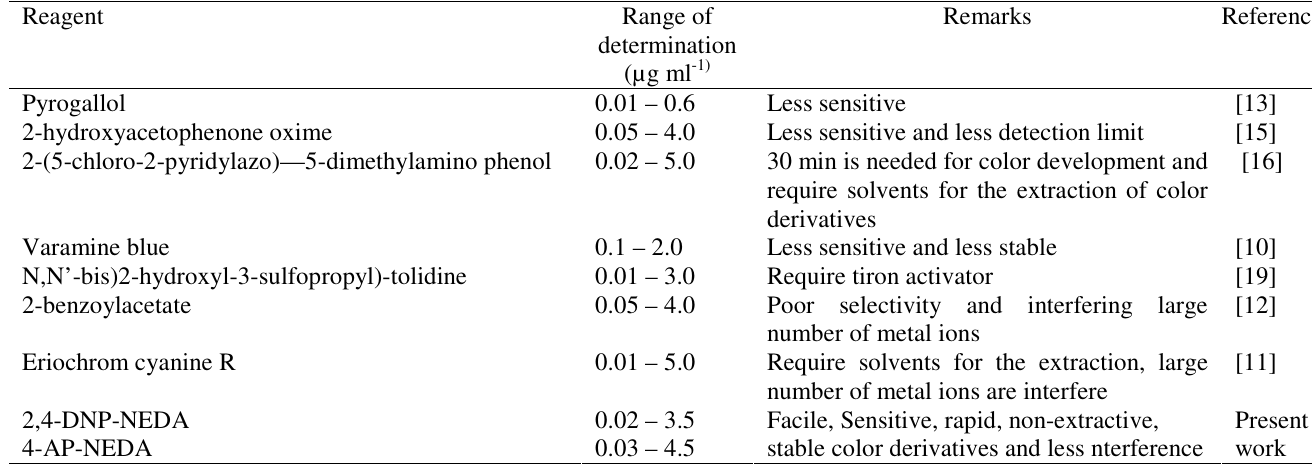
Table 4. Comparison of spectrophotometric and catalytic photometric methods for the determination of vanadium (V) with 2,4-DNPH-NEDA and 4-AP-NEDA